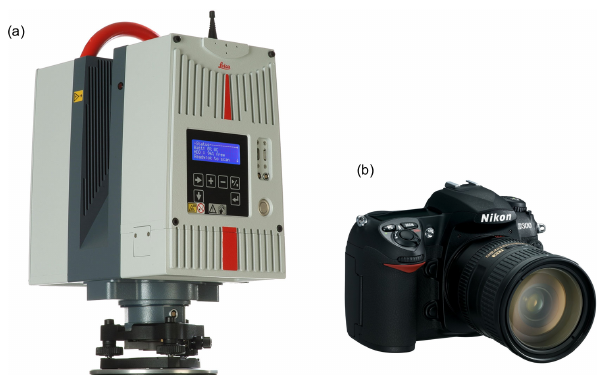
Figure 1. (a) The Leica HDS-6200 TLS; (b) the digital reflex cam- era Nikon D300 used in this work.